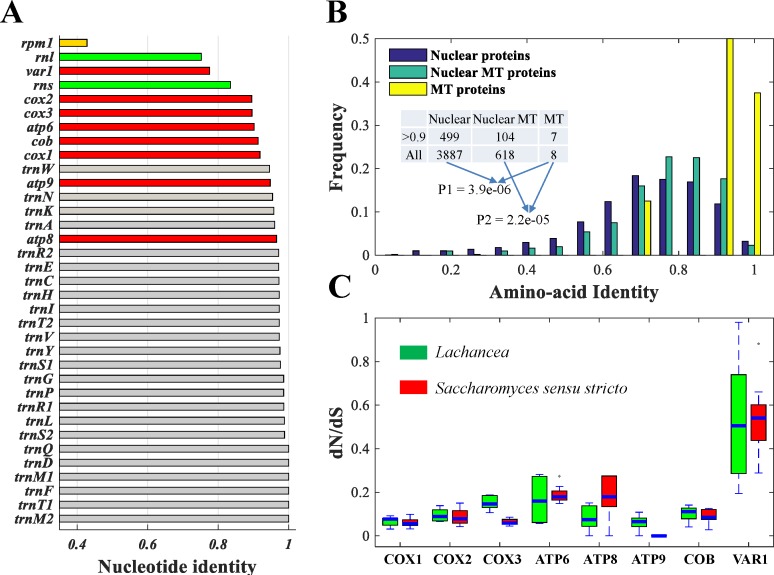
(A) The nucleotide identities of all mitochondrial genes in the Saccharomyces sensu stricto group. The nucleotide identity was calculated based on the proportion of completely conserved nucleotides in multiple sequence alignments of five SSS yeasts conducted using ClustalOmega. The red bars represent protein-coding genes; the green bar is rRNA; the gray bar is tRNA and the yellow bar is rpm1. (B) Comparison of amino-acid identities among nuclear proteins, nuclear MT proteins and mitochondrial proteins. We identified 3,887 nuclear proteins which are present in all five SSS yeasts. Among them, 618 proteins were located in the mitochondria. The amino-acid identity for each protein was calculated based on the proportion of completely conserved amino-acid residues in the multiple sequences alignment (MSA) results. The dark blue, green and yellow bars represent the distribution of nuclear proteins, nuclear MT proteins and mitochondrial proteins, respectively. The table insert indicates the number of proteins which have identities greater than 90% in three protein sets. The p-values were calculated based on a hypergeometric test whether the number of MT proteins with high identity was significantly greater than those in the other two protein sets. (C) Box-plot comparisons of the dN/dS ratios estimated for the eight MT protein-coding genes between the genus Lachancea and the Saccharomyces sensu stricto linage.